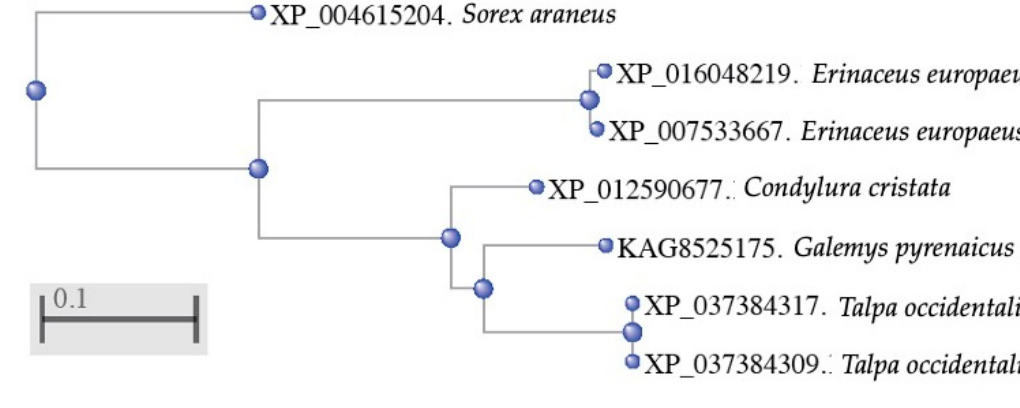
Figure 4. Phylogenetic tree constructed using alignment of the exons 1-3 of annotated cathelicidins from the Eulipotyphla order. Multiple sequences comprised the Iberian desman ( Galemys pyrenaicus ), the European hedgehog ( Erinaceus europaeus ), the common shrew ( Solex araneus ), the star-nosed mole ( Condylura cristata ) and the Iberian mole ( Talpa occidentalis ). The phylogenetic tree was constructed using the COBALT tool [17], from the NCBI, with the Fast Minimum Evolution algorithm. Table 1. Amino acid sequence of the putative antimicrobial peptide for the annotated cathelicidin sequences (accessed on 9 May 2022) of mammals of the Eulipotyphla order, including Talpa occidentalis . Shaded residues correspond to the alpha helix portion of the peptide according to the models predicted with the Alphafold server. Residues in red represent the LPS binding domain of CAP18 (identified by its similarity with